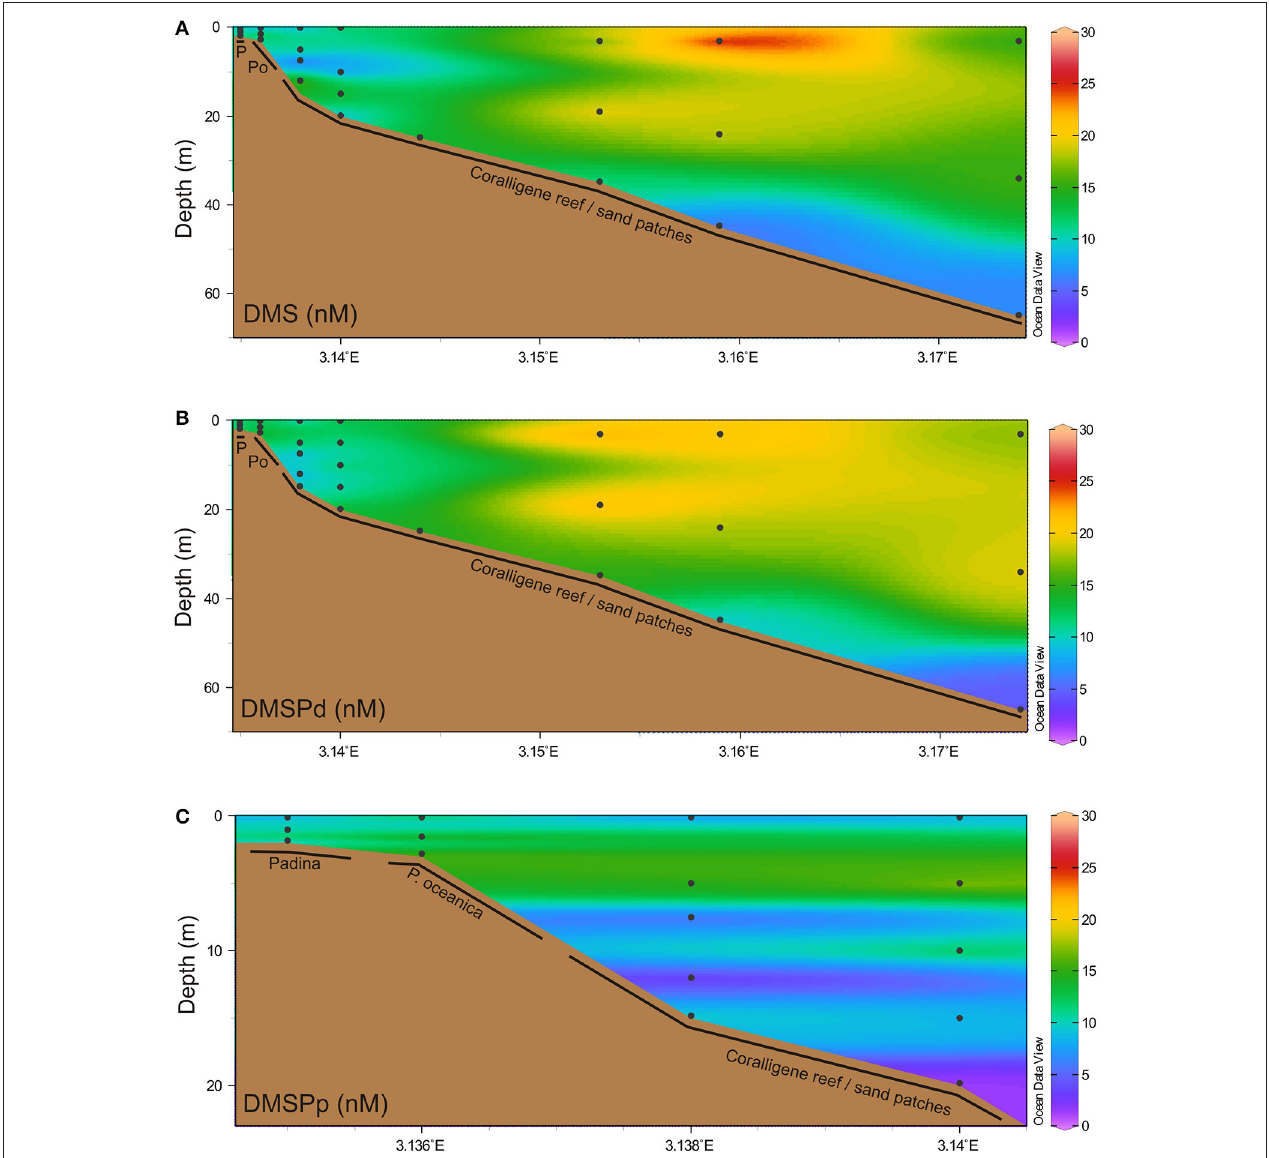
FIGURE 2 | Water column concentrations of dimethylated sulfur. Water column concentrations (nM) of (A) DMS, (B) dissolved DMSP (DMSPd), and (C) particulate DMSP (DMSPp). Black dots indicate discrete sampling locations. P, Padina ; Po, Posidonia oceanica